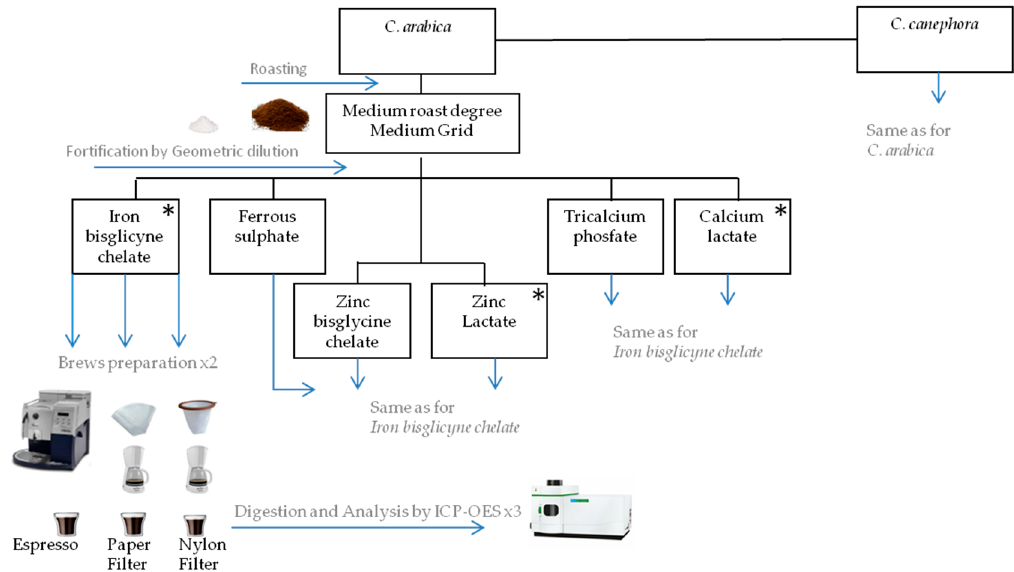
Figure 1. Scheme for the evaluation of minerals recovery in coffee brews after preliminary sensory test. Salts indicated with stars were the most well accepted among salts remaining in the study.